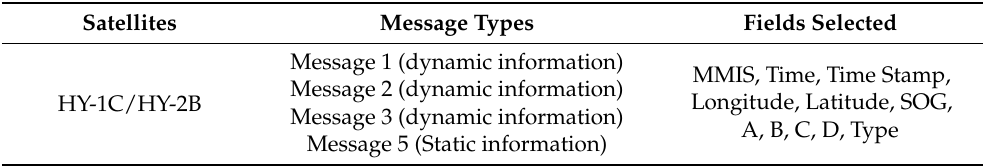
Table 1. Introduction to the AIS data